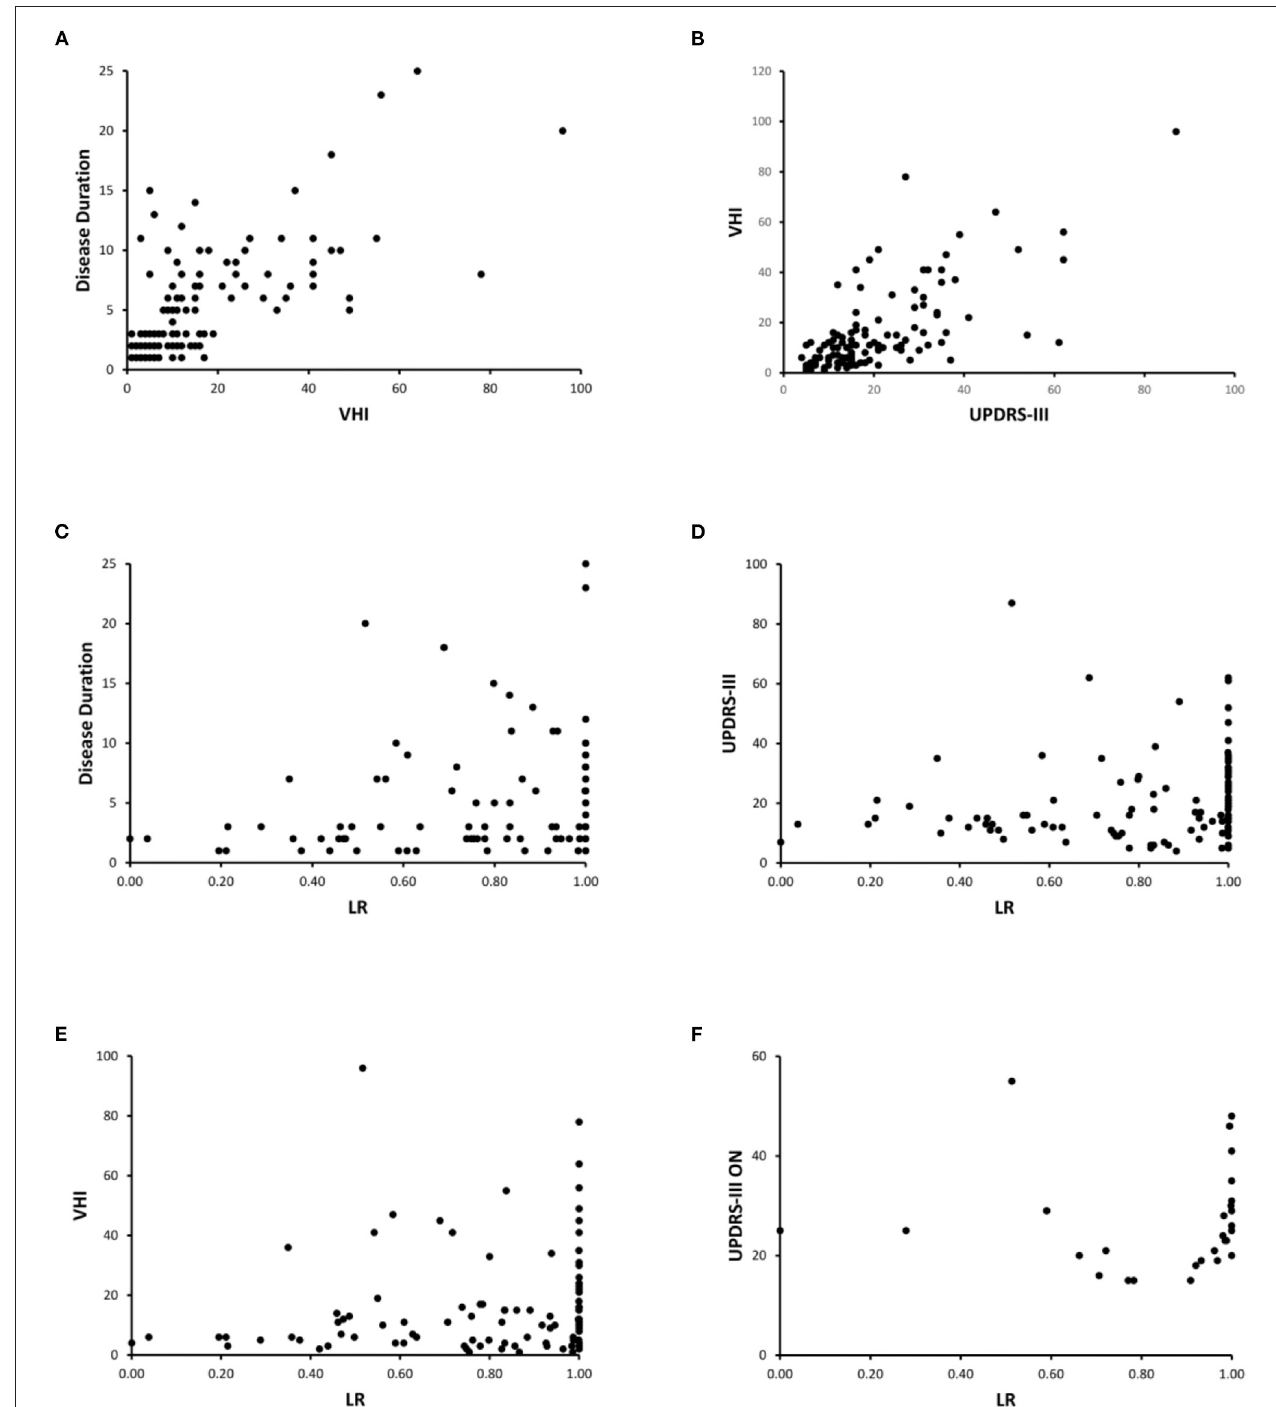
FIGURE 4 | Clinical-instrumental correlations. (A) Disease Duration and VHI; (B) UPDRS-III and VHI; (C) Disease Duration and LRs; (D) UPDRS-III and LRs; (E) VHI and LRs; (F) UPDRS-III ON and LRs. Note that the correlation analysis only refers to the emission of the vowel. Similar results have been achieved when analyzing the emission of a sentence (data not shown). In addition, correlation analysis shown in (A–E) refers to the whole group of PD patients, whereas (F) shows the correlation assessed in the subgroup of mid-advanced stage patients ON therapy.